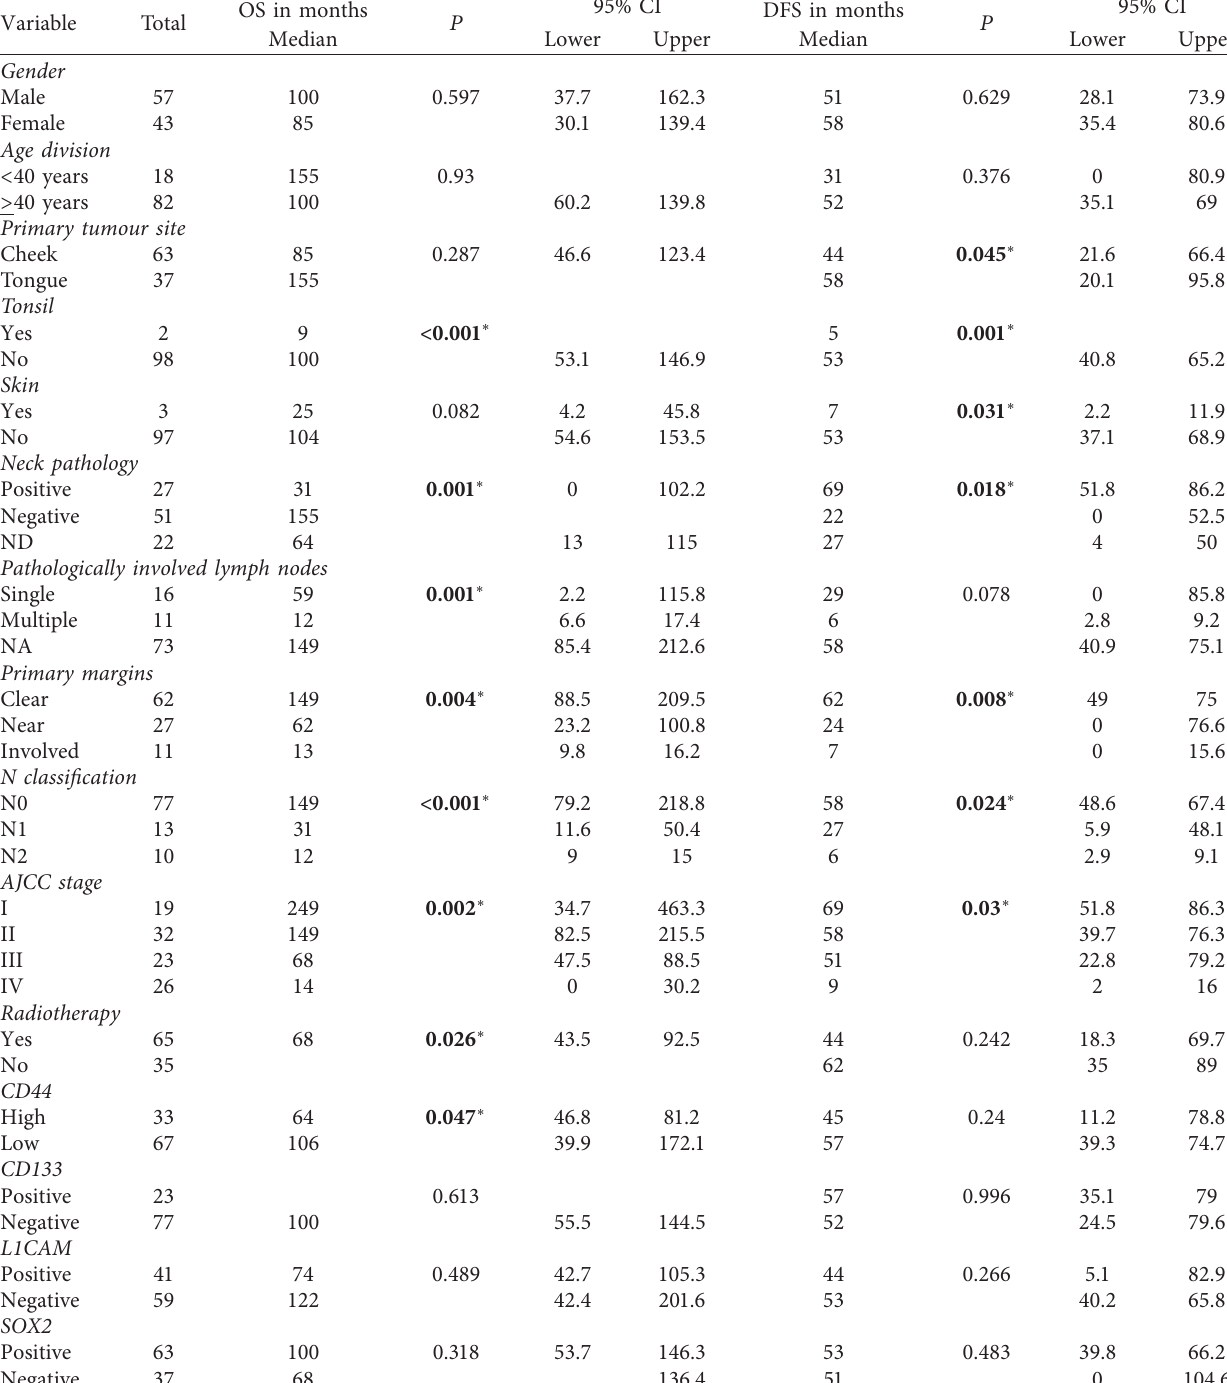
Table 5: Kaplan–Meier (log-rank statistic) analysis for overall survival and disease-free survival ( n � 100).